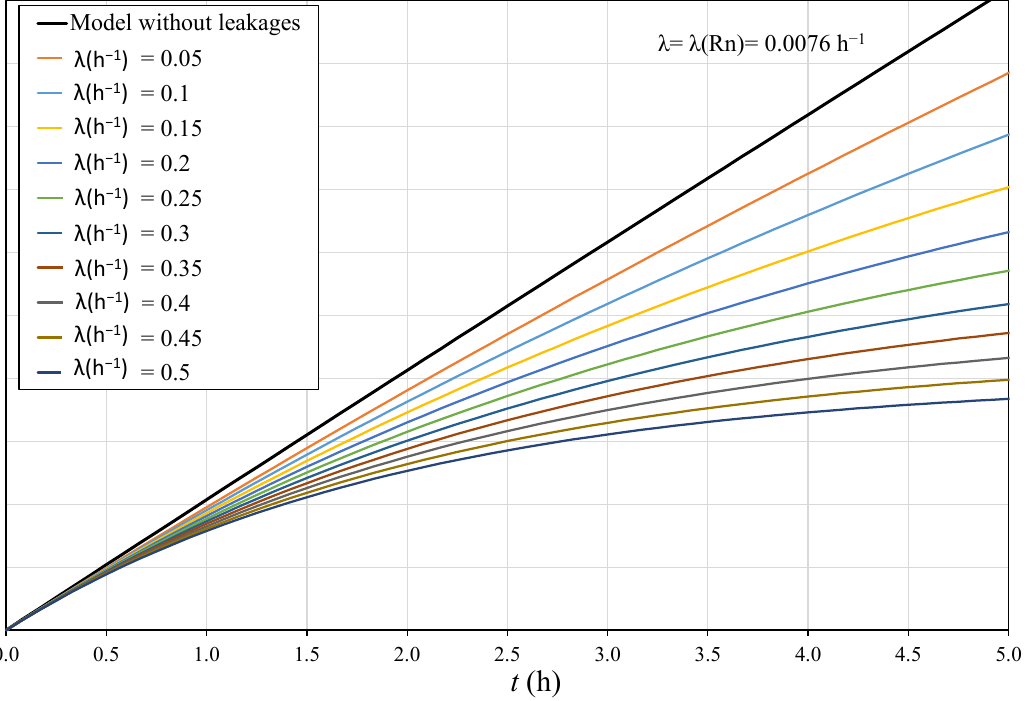
Figure 5. Theoretical approach of radon concentration over time for the first 5 h depending on λ (h − 1 ) for the same radon flux value. Curves obtained from Equation (2) with a time interval of 10 min.